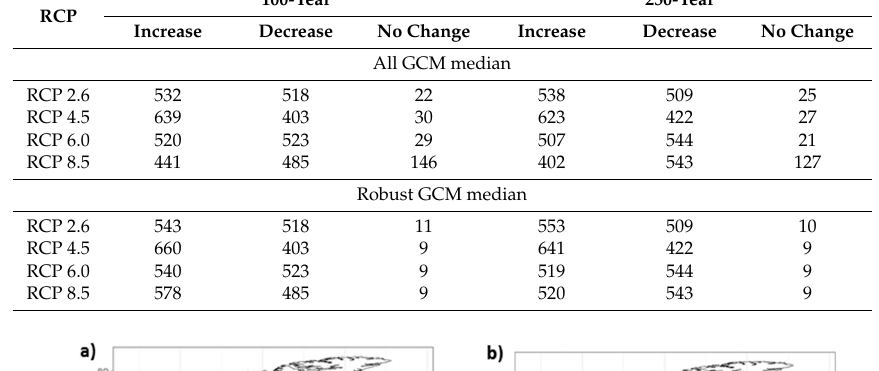
Water 2019 , 11 , x FOR PEER REVIEW